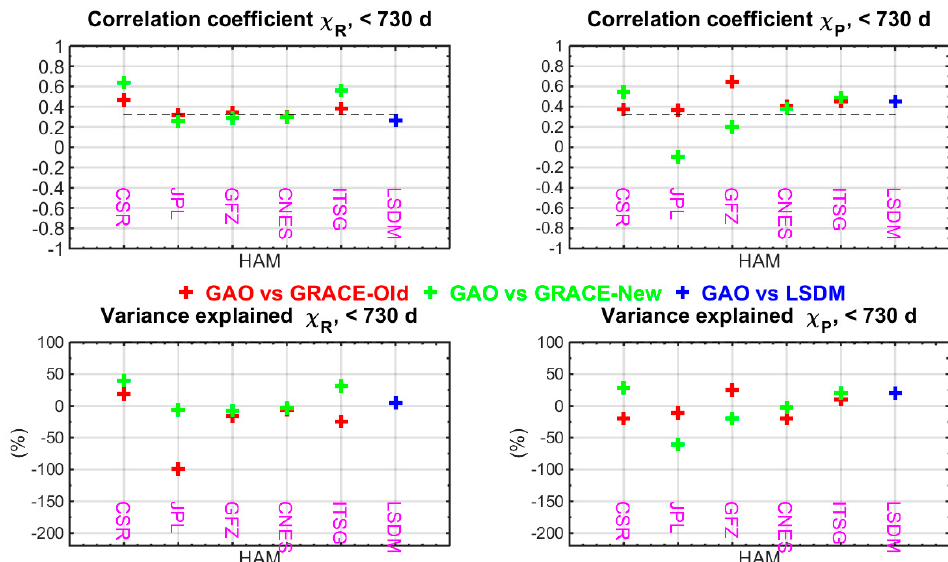
Figure 11. Correlation coefficients of χ R and χ P parts of short-term (<730 days) non-seasonal variation between GAO and HAM computed from GRACE solutions and the LSDM and the percentage of variance in GAO explained by HAM functions. The critical value of the correlation coefficient for 25 independent points and a confidence level of 0.95 was 0.34. The standard error of the difference between two correlation coefficients for 25 independent points was 0.30.